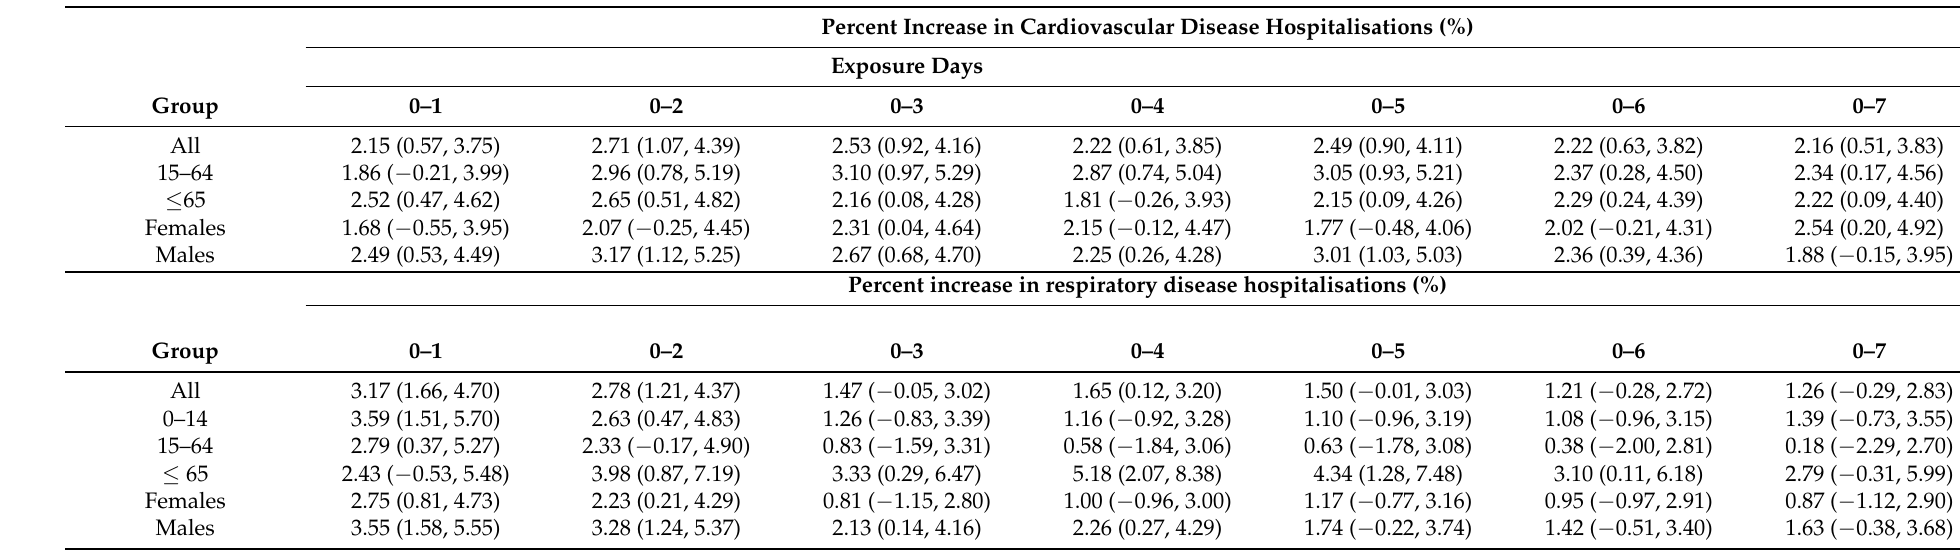
Table A1. Percent change (mean and 95% CI) of CVD and RD hospitalisations associated with an interquartile range (IQR) increase in temperature variability ( ◦ C) on different exposure days, adjusting for time trends and seasonal variation, day of the week, public holidays, and daily mean